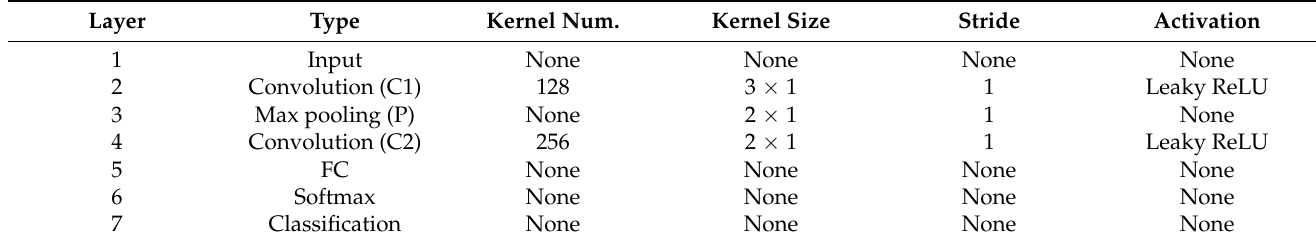
Table 1. Structural parameters of the 1-D